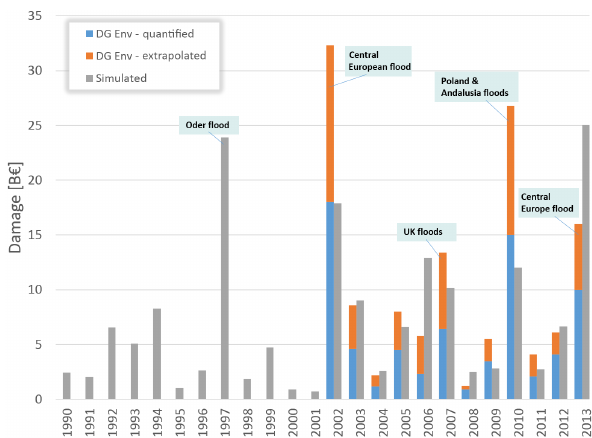
Figure 5. Annual estimates of flood damage in the EU over 1990– 2013 (PPS of 2013) using the event-based method (in grey) and comparison with data by DG Env (Fenn et al.,